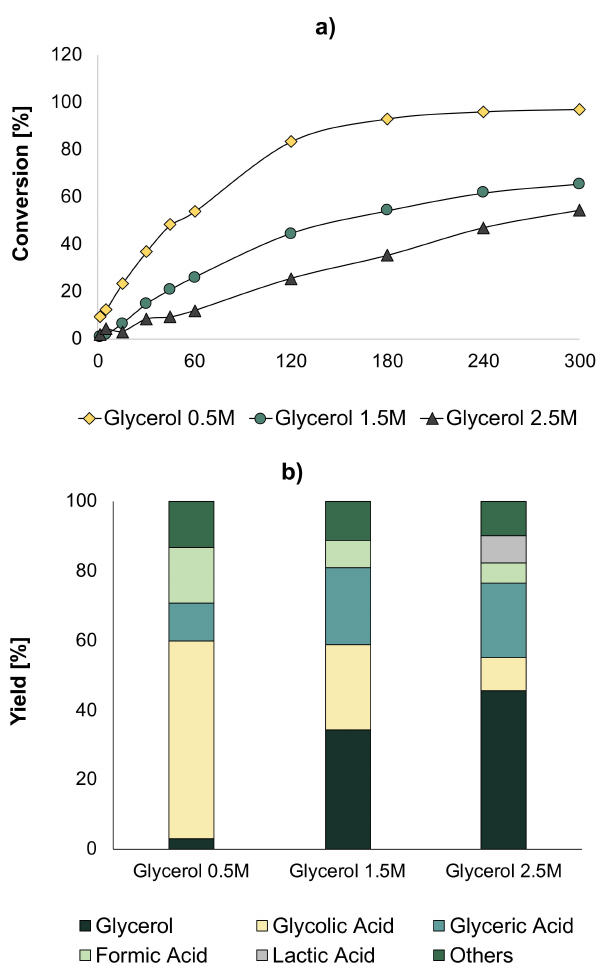
Figure 7. ( a ) Conversion and ( b ) products’ yields obtained by increasing glycerol concentration at optimal conditions of temperature (60 ◦ C), NaOH/glycerol ratio, and amount of catalyst (0.7 g).